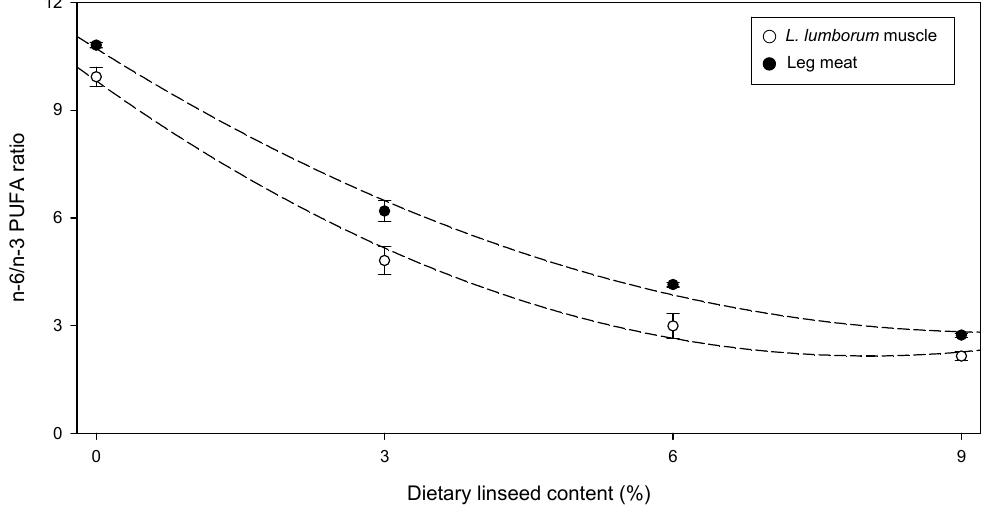
Figure 2. Relationship between dietary linseed content and n-6/n-3 PUFA ratio (mean ± sem) in rabbit meat ( L. lumborum muscle: y = 0.09x 2 − 1.68x + 10.7, R 2 = 0.995;